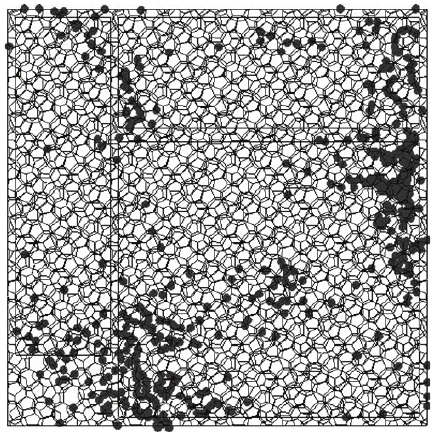
Figure 4: The plastic hinge state of roof by moment 𝑀 𝑧 .